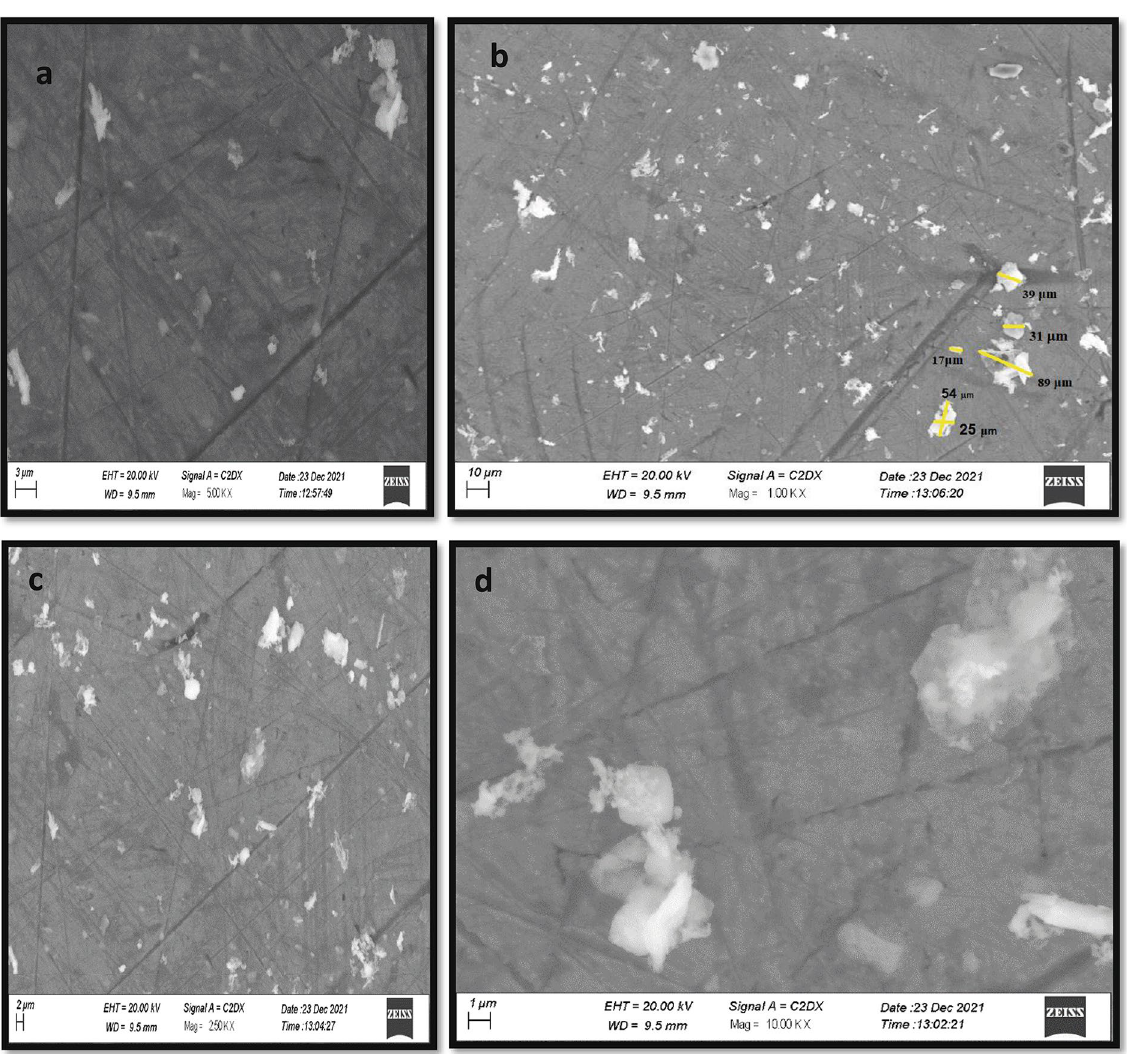
Figure 6. SEM images of fly